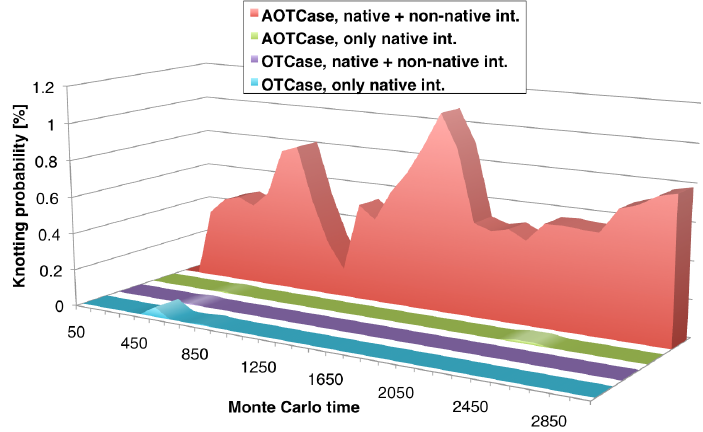
Figure 7. Monte Carlo time-evolution of the average knotting probabilities of the natively-knotted AOTCase and of the unknotted OTCase starting from unfolded conforma- tions up to a stage when about 35% of the native contacts are formed. For each protein, it the average knotting probability is shown as observed when using a purely native-centric force field and with the addition of non-native quasichemical interactions. Adapted with permission from